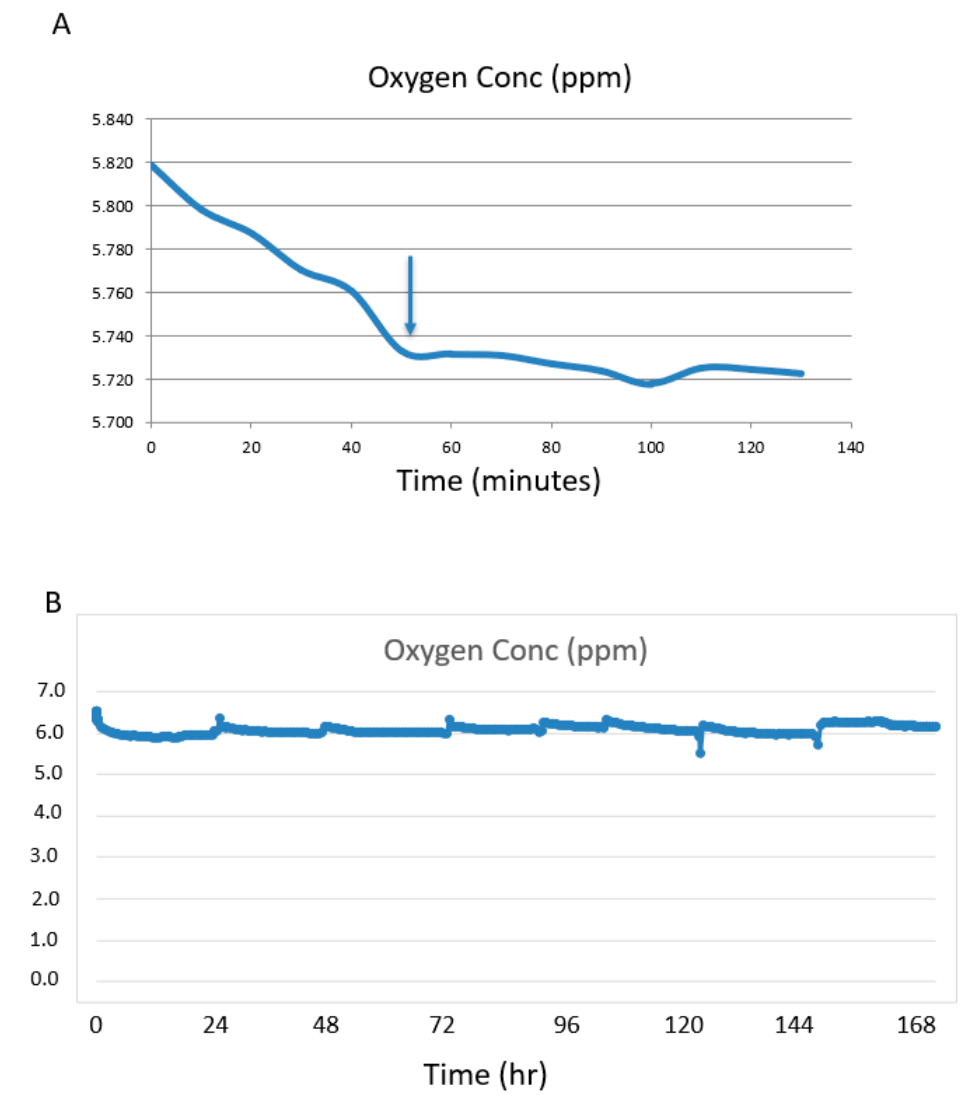
Figure 2. Changes in oxygen concentration of the media at the beginning and end of a 24 h ex vivo perfusion cycle. ( A ) Oxygen levels of the medium before the kidney is attached starts at 5.82 ppm at time =0 at 4 °C and levels off at ~5.7 ppm after 50 min at 37 °C (arrow). ( B ) The last 180 min of a 24 h ex vivo perfusion cycle depicts the drop in oxygen concentration due to the consumption of oxygen by the kidney. To confirm the drop in oxygen concentration was due to the kidney, the kidney was removed at t = 21 h and the medium oxygen concentration increased to levels observed before the kidney was attached.